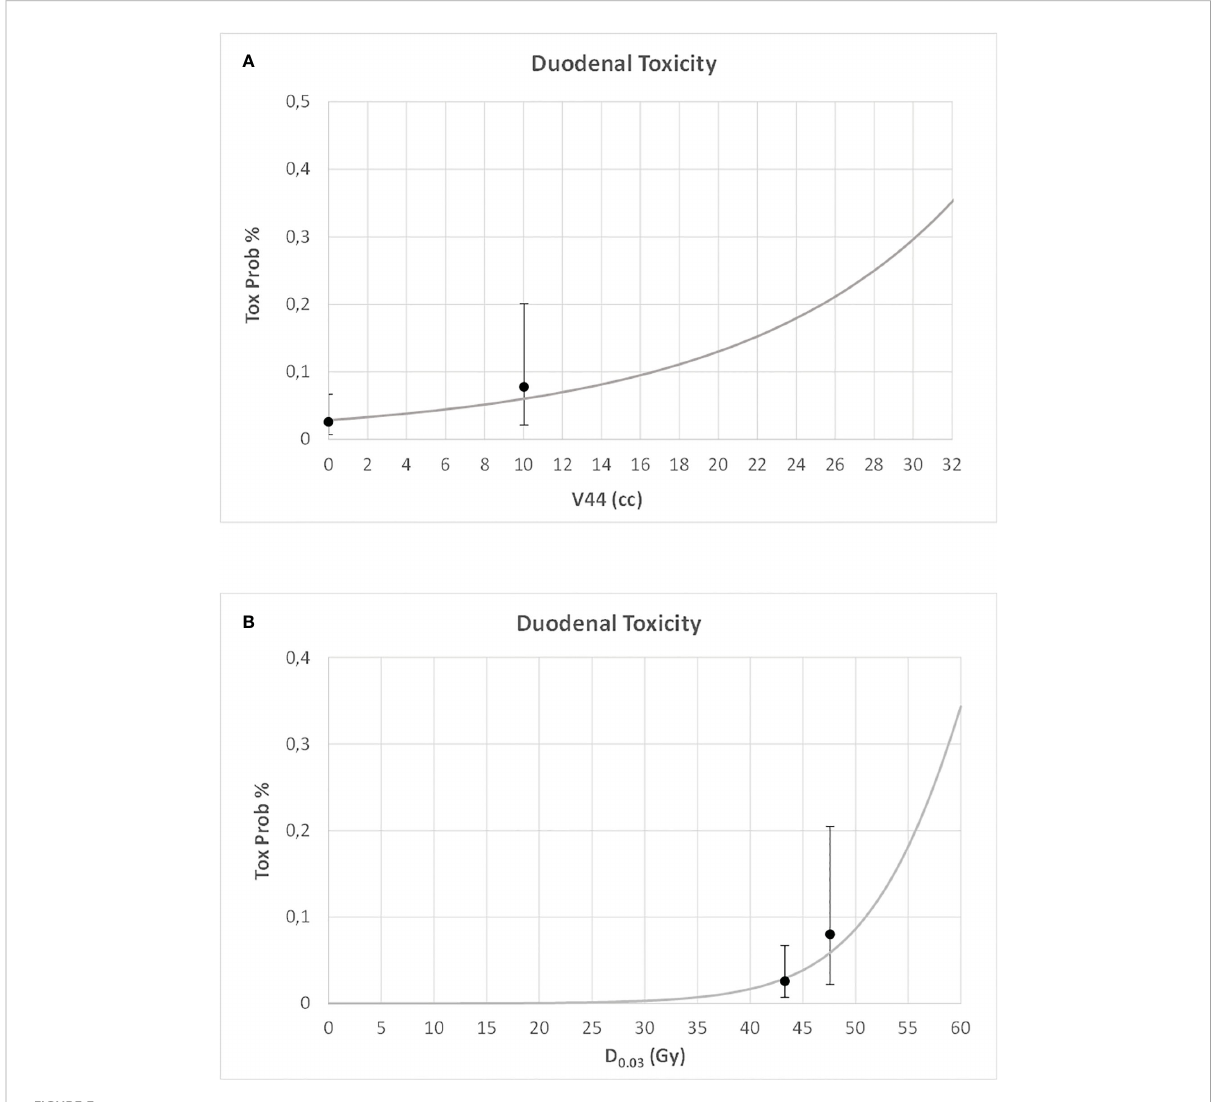
FIGURE 3 Risk of duodenal toxicity against duodenum V44 (A) and maximum dose (B) (D0.03), together with the true rates and their standard